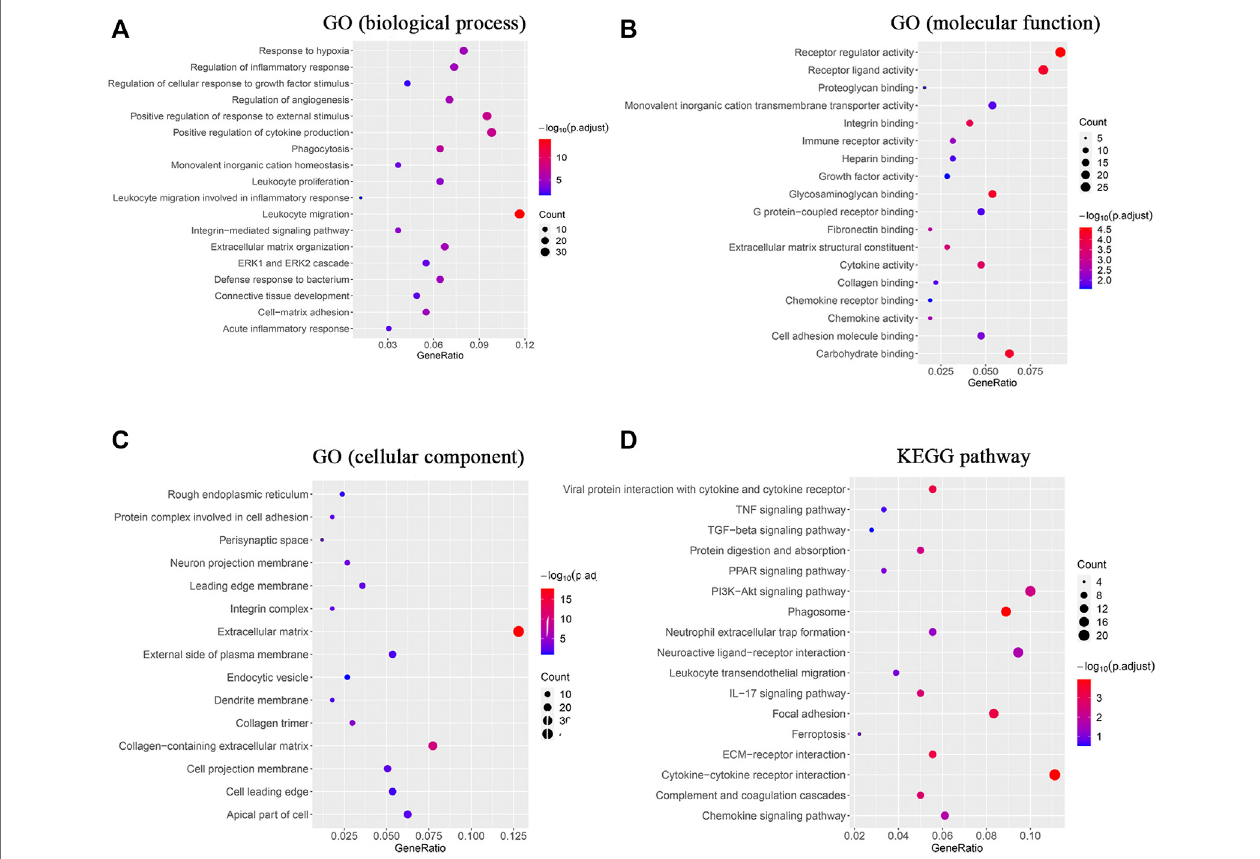
FIGURE3| GOenrichmentanalysisandKEGGanalysisrevealedchangesinthesignalingpathwaysandmolecularresponseofskintissueduringtheFBRinduced by silicone implants. (A) GO enrichment analysis of the DEmRNAs in biological processes. (B) GO enrichment analysis of the DEmRNAs in molecular functions. (C) GO enrichment analysis of the DEmRNAs in cellular components. (D) KEGG analysis of the DEmRNAs. Gene ratio indicates the number of DEmRNAs associated with the GO term divided by the total number of DEmRNAs. Dot size represents the number of DEmRNAs associated with the GO term and the color represents the negative value of log10 of adjusted p -value. KEGG, Kyoto Encyclopedia of Genes and